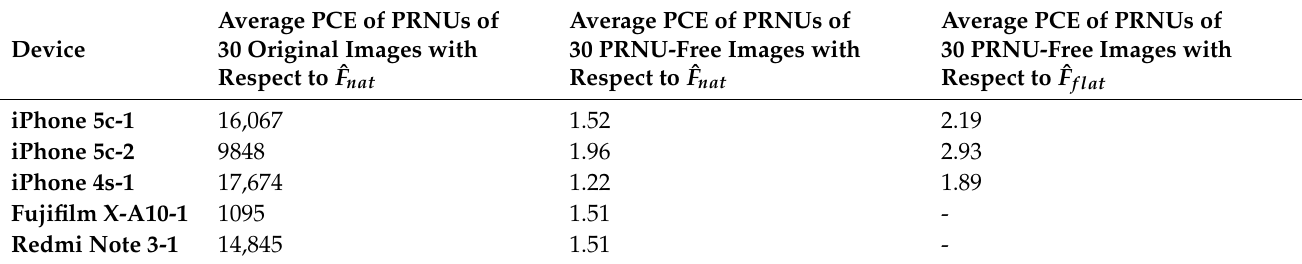
Table 2. PCE evaluation of the PRNUs extracted from the original and downsampled images with respect to ˆ F nat and ˆ F flat